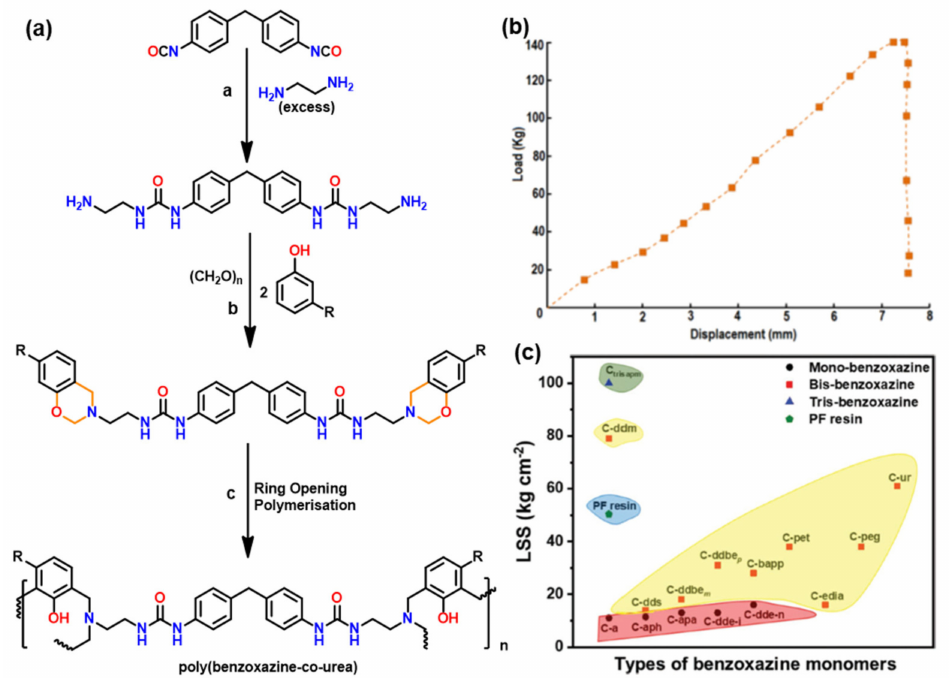
Figure 21. ( a ) Synthesis of main chain-type urea linked polybenzoxazine and ( b ) representative stress-strain curve for a stainless steel coupon held together with poly(benzoxazine-co-urea) as adhesive for LSS measurement [225]. Copyright 2017. Reproduced with permission from John Wiley & Sons, Inc. ( c ) Adhesive strength of polybenzoxazines based on cardanol [90]. Copyright 2018. Reproduced with permission from WILEY-VCH Verlag GmbH & Co. KGaA, Weinheim,